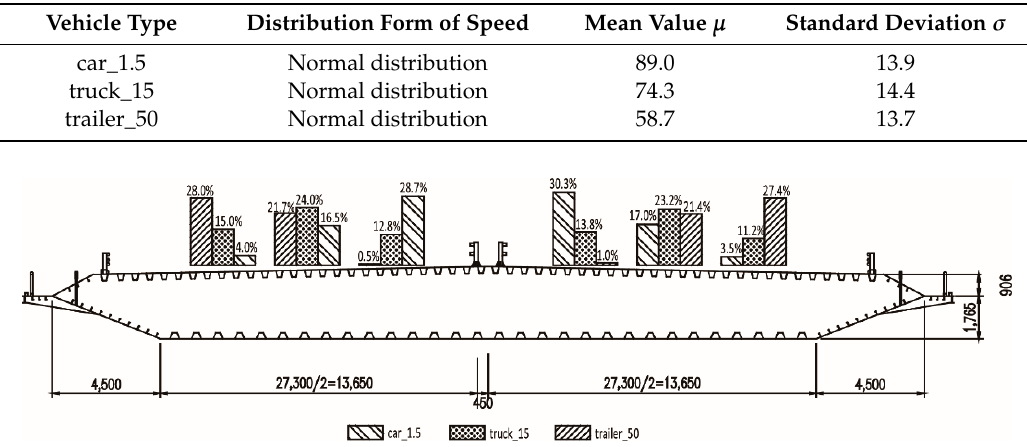
Figure 12. Distribution form of vehicle speed of the three typical vehicle types. Table 5. Distribution form and relative parameters of vehicle speed.